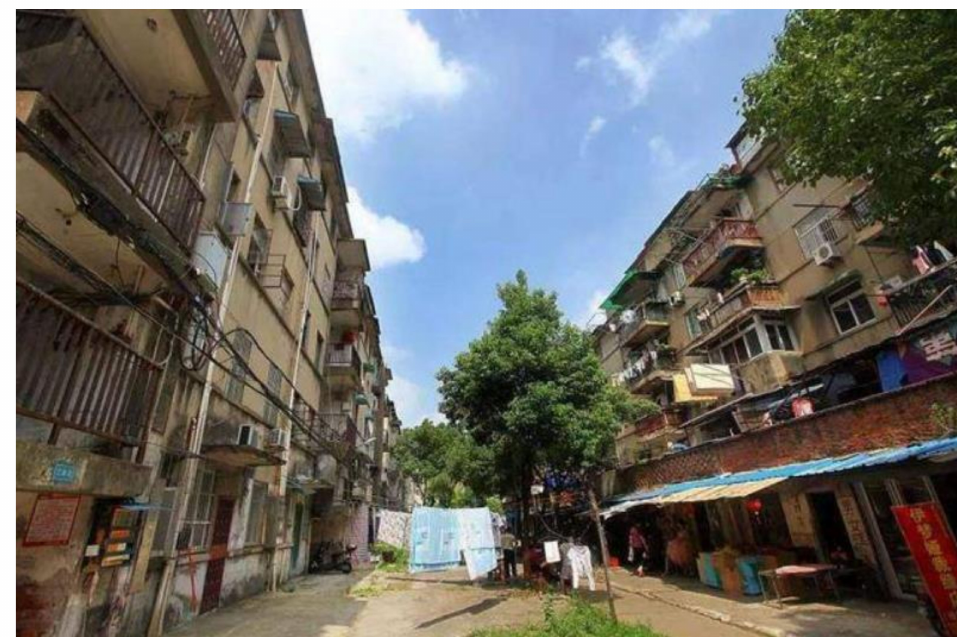
Figure 2. Buildings and green spaces in old residential neighborhoods.